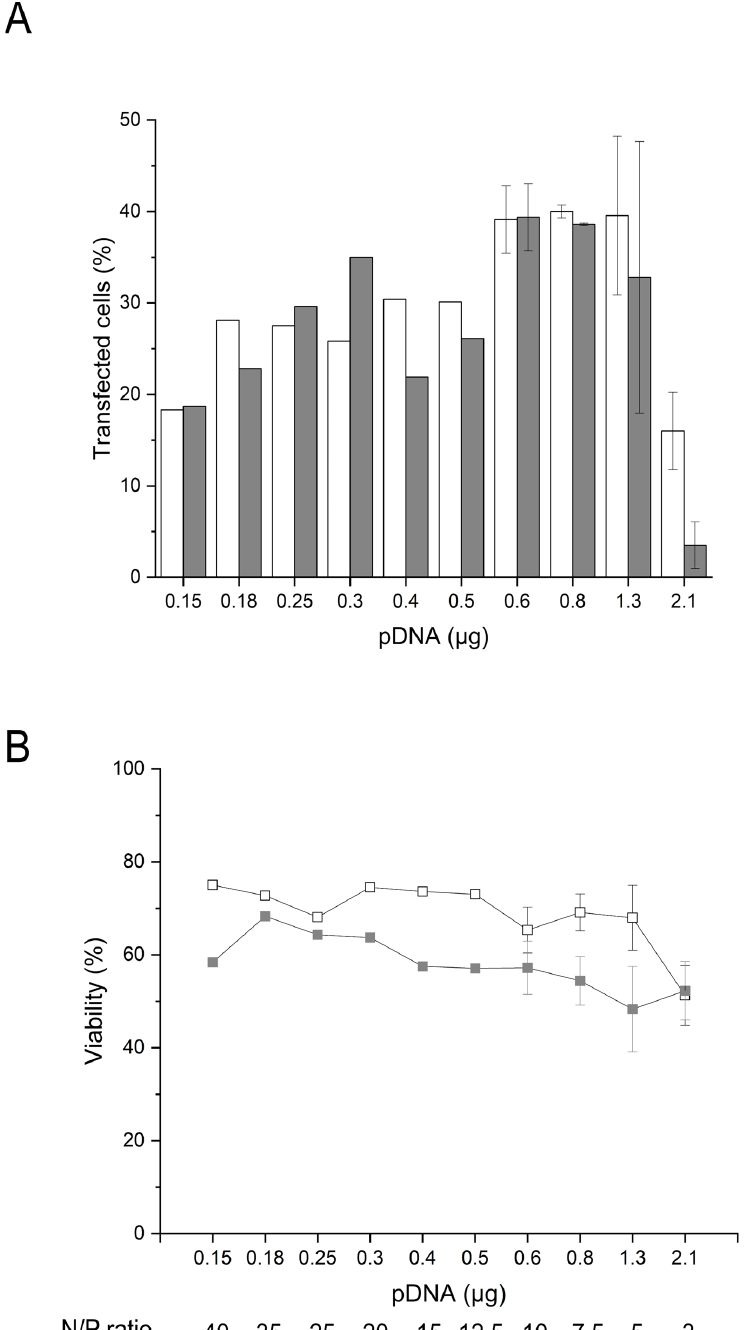
Figure 4. Influence of pDNA amount and cultivation post-transfection on transfection efficiency and viability. Transfection in tubes day 4 post-thawing. TE ( A ) and viability ( B ) measured 24 h (white) and 48 h (grey) post-transfection. Cell number during transfection: 2 × 10 5 cells. Polymer density: 15 µg mL − 1 , polymer concentration: 6 µg mL − 1 . Contact time: 30 min. Transfection volume: 0.5 mL. Viability of the mock-transfected cells: 97.9 ± 0.3 % (24 h); 97.9 ± 1.4 % (48 h). Cell viability on the day of transfection: >80%. Shown are mean values ± SD, n ≥ 2 (N/P ratio 3 to 10) and results of a single transfection (N/P ≥ 12.5, n = 1).